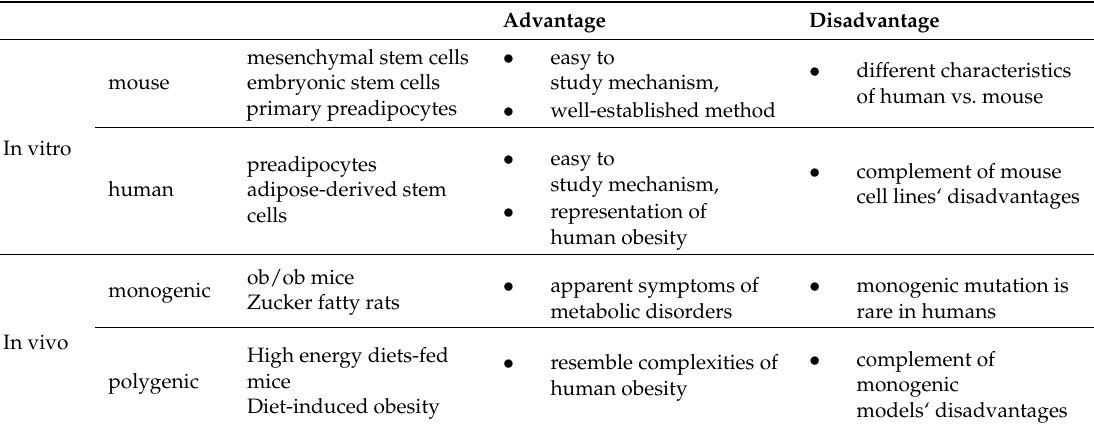
Table 1. Frequently used obesity model in vitro and in